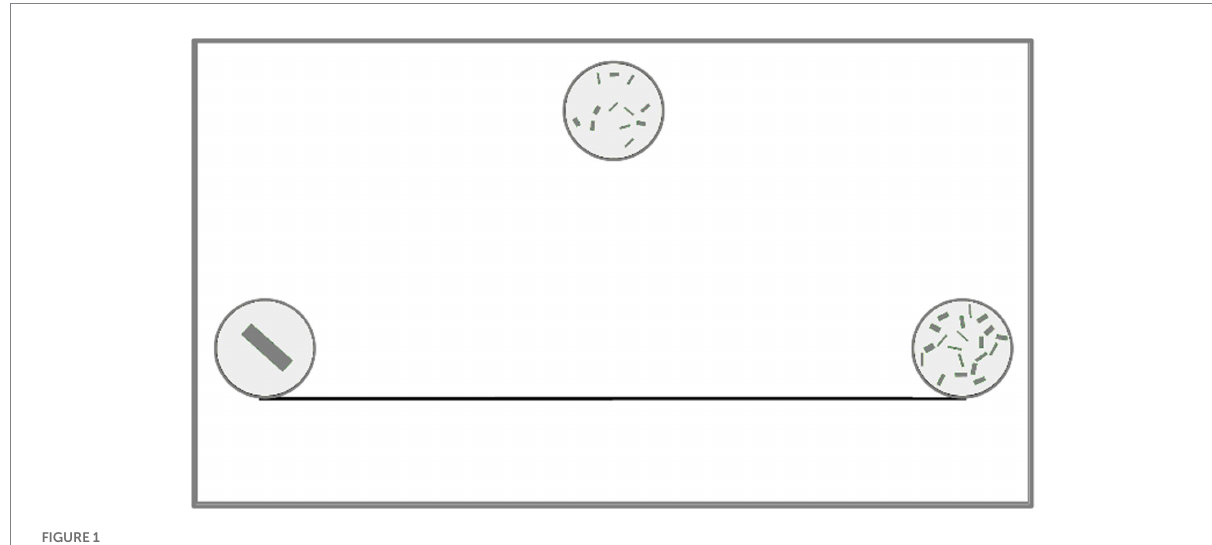
FIGURE 1 Experiment 1: test trials screen layout: 1–20, left-to-right oriented